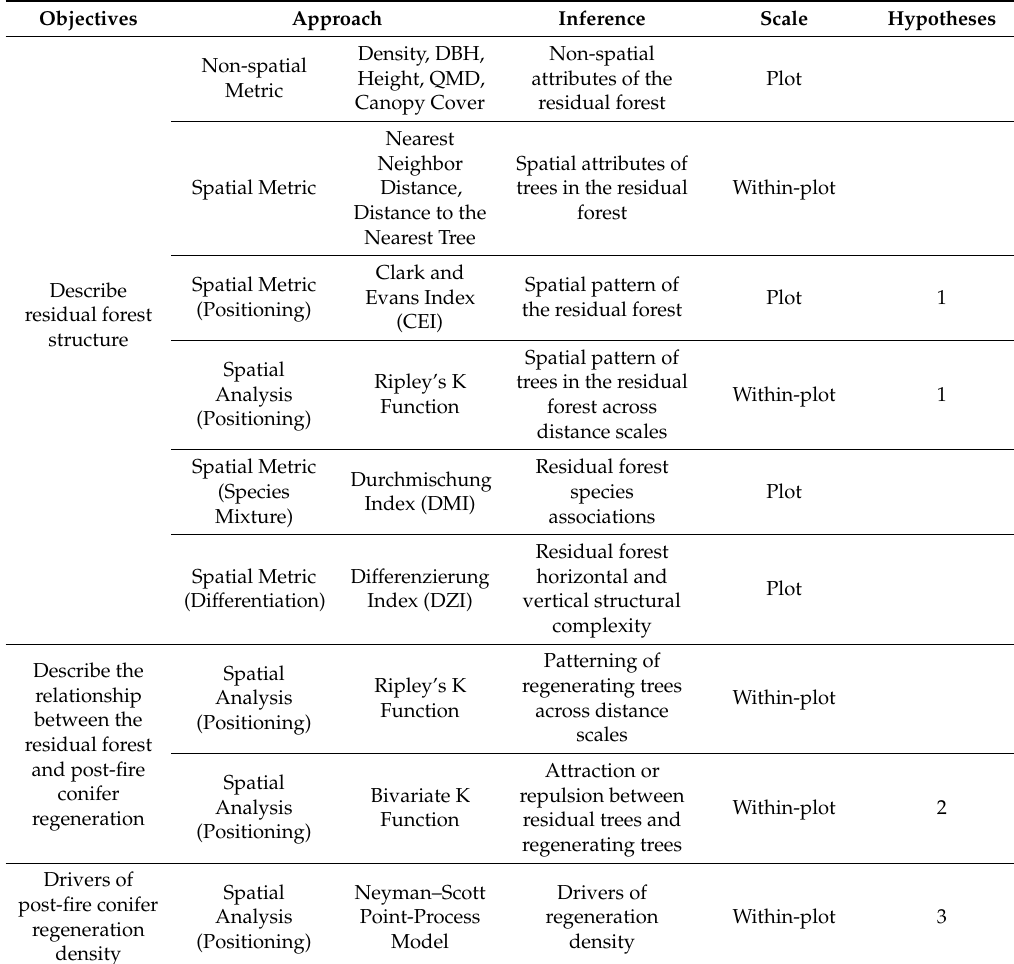
Table 1. Non-spatial and spatial measures of forest structure used to evaluate study objectives and